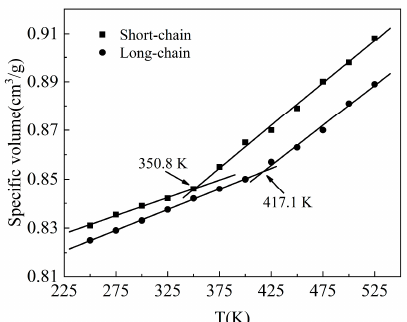
Figure 2. Specific volume versus temperature for chain polycarbonates (PCs) of different chain lengths.